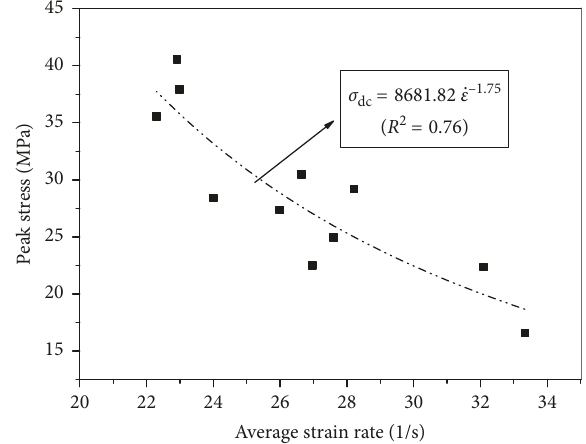
Figure 10: Relationship between average strain rate and peak